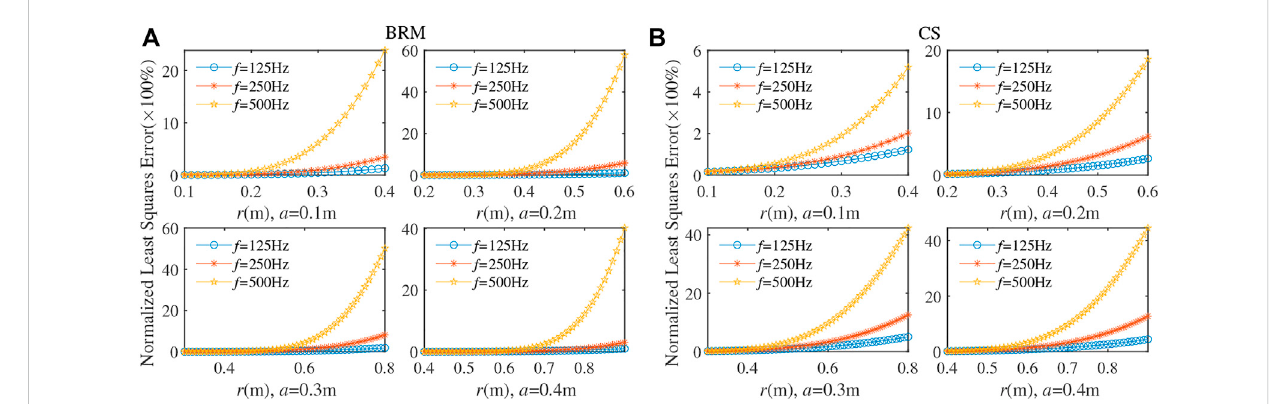
FIGURE 4 Thepressureleastsquareerrorsasafunctonofthefrequencyfordifferentsphericalarrayradius.ThesimulationresultsoftheBRMandCSareshown in (A) and (B) ,